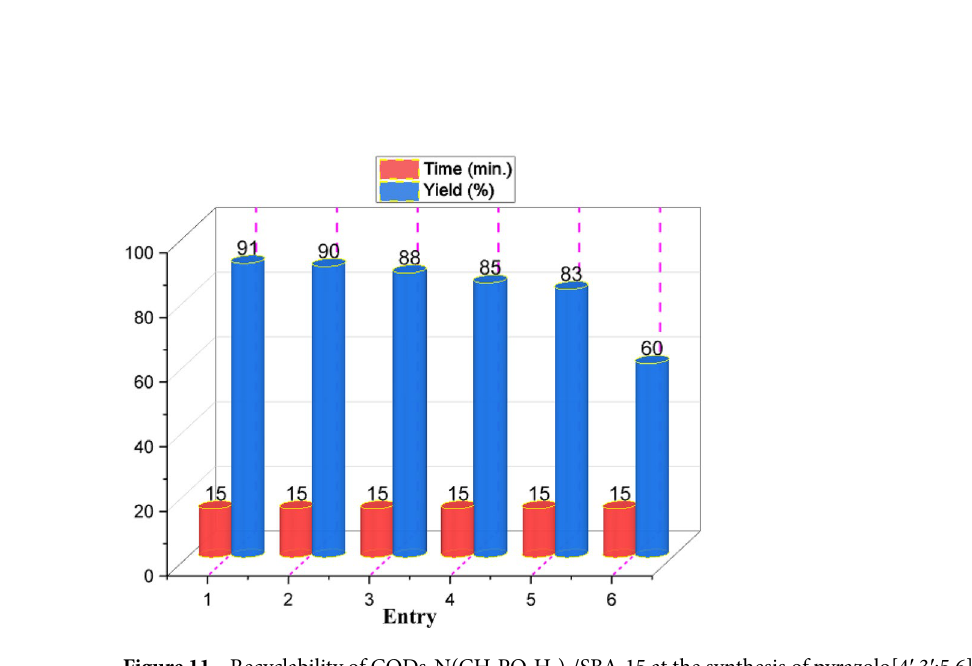
Figure 11. Recyclability of CQDs-N(CH 2 PO 3 H 2 ) 2 /SBA-15 at the synthesis of pyrazolo[4 ′ ,3 ′ :5,6]pyrido[2,3- d ]